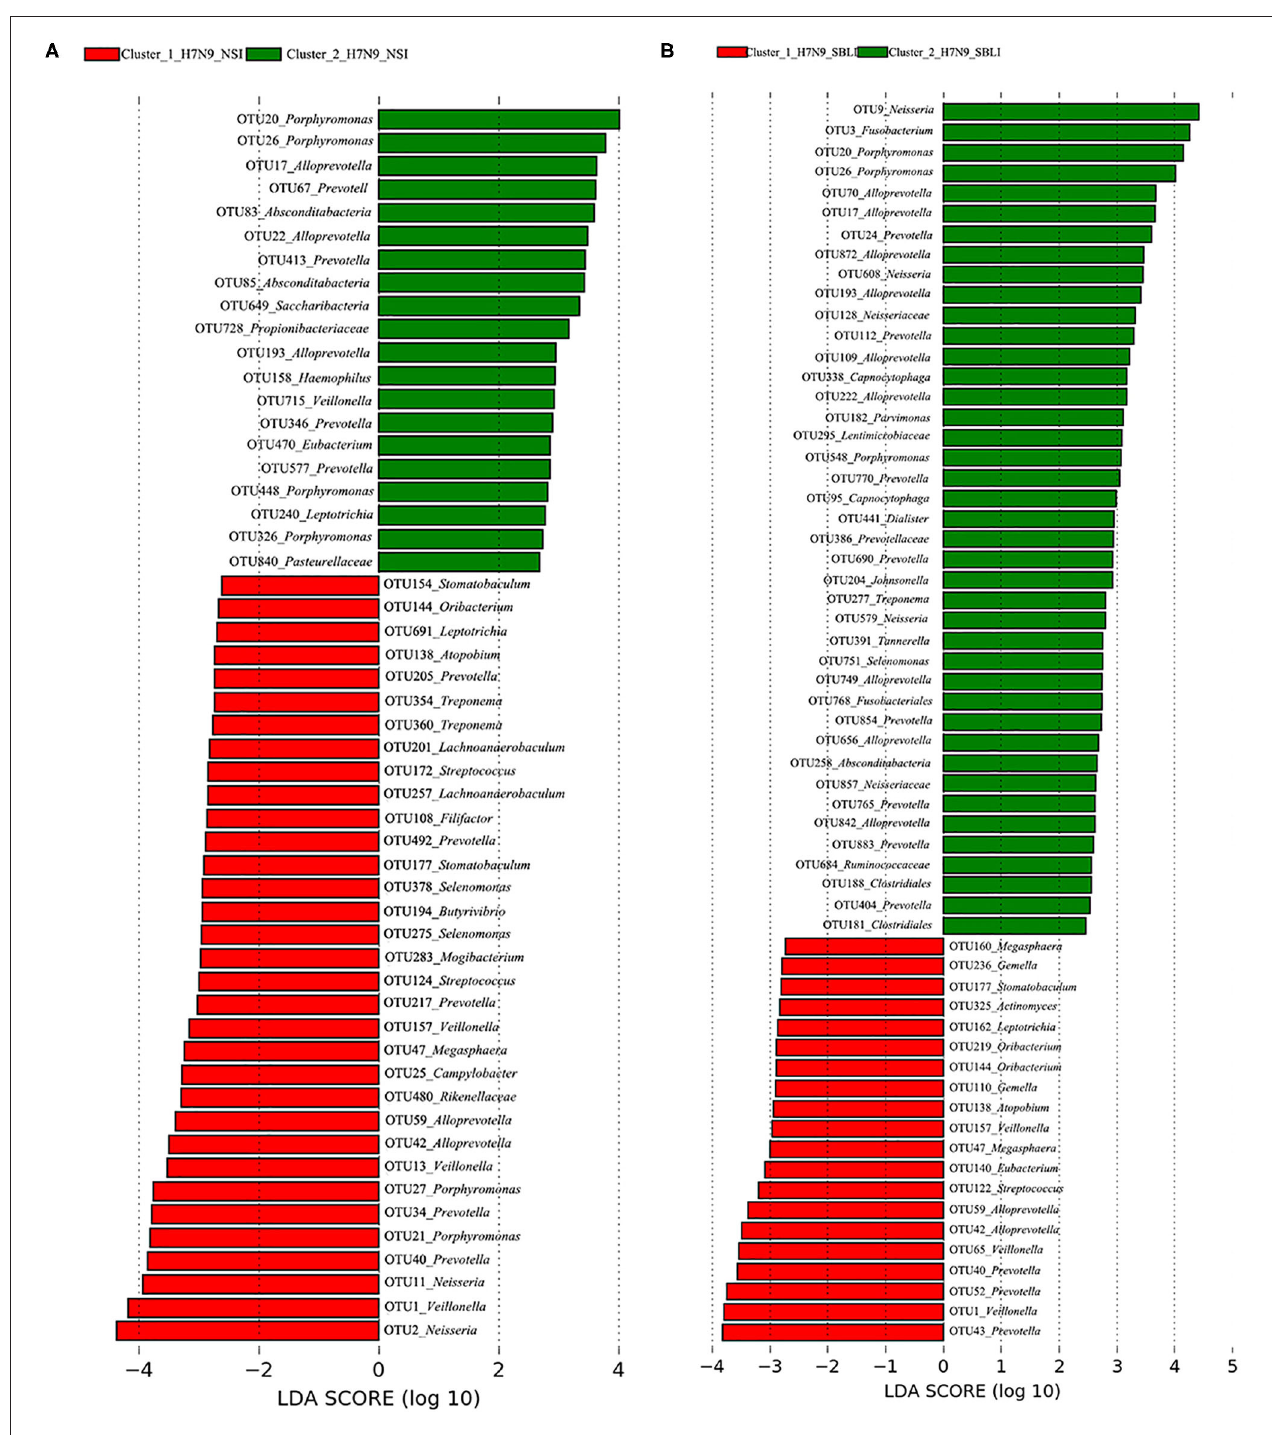
FIGURE 4 | Operational taxonomic units associated with each of the two clustered OP microbiotas of (A) H7N9 patients with no secondary bacterial lung infection (H7N9_NSI) and (B) H7N9 patients with secondary bacterial lung infection (H7N9_SBLI).